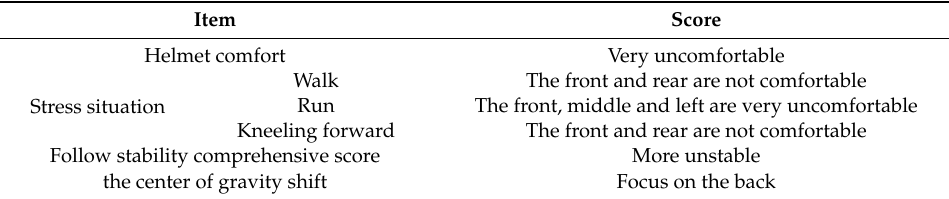
Table 2. Summary of the helmet comfort questionnaire.